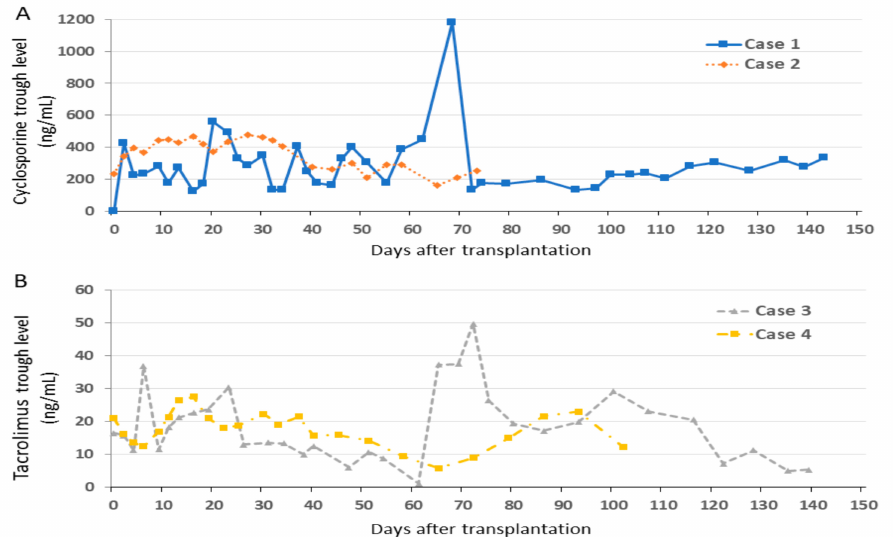
Figure 1. Changes of trough level in immunosuppressive treatment. ( A ) Cyclosporine concentrations in cases 1 and 2. ( B ) Tacrolimus concentrations in cases 3 and 4.